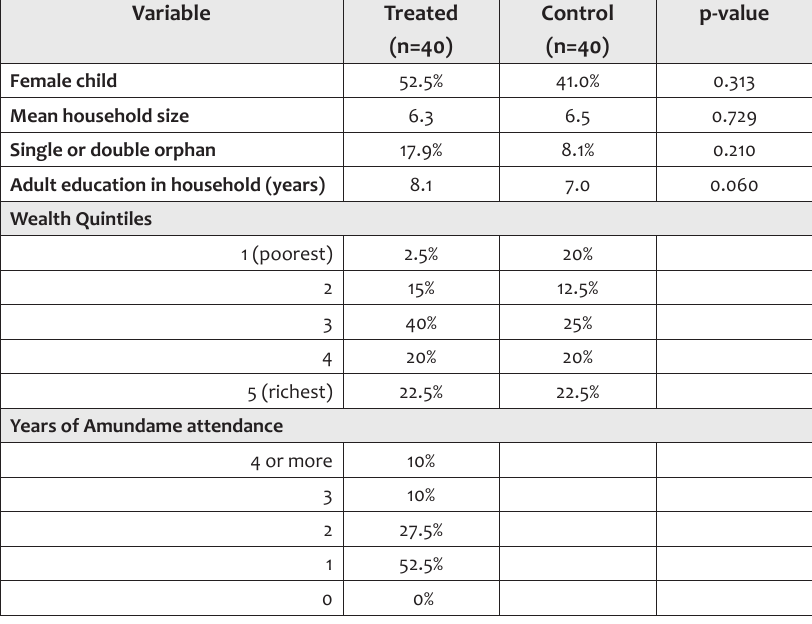
Table 1: Description of the sample Variable